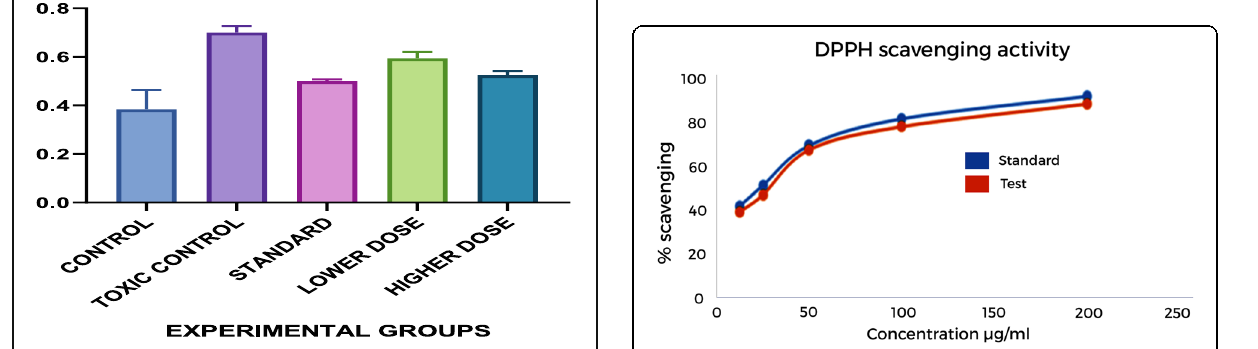
Fig. 10 DPPH Scavenging